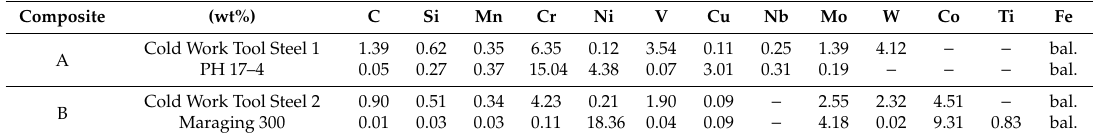
Table 1. Composition of the alloys. Composite A consists of the cold work tool steel 1 and a precipitation hardening (PH) steel. Composite B consists of the cold work tool steel 2 and a maraging steel. Composite (wt%) Cold Work Tool Steel 1 A Cold Work Tool Steel B